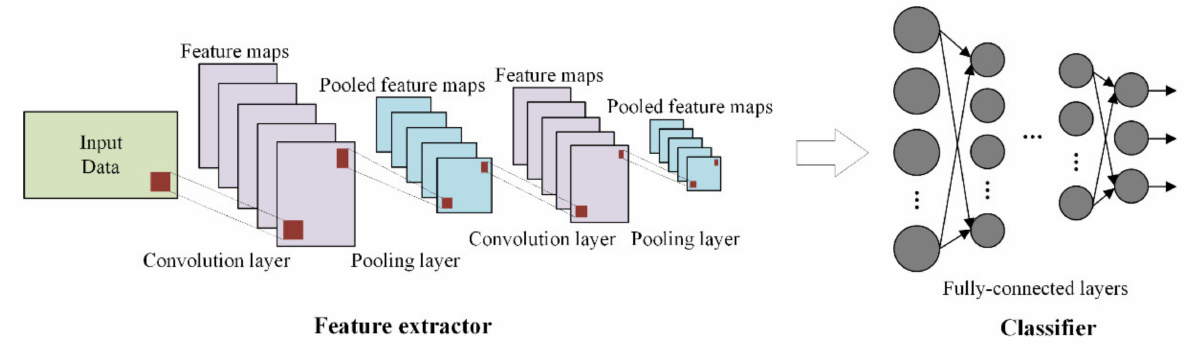
Figure 3. The basic structure of the Convolutional Neural Network (CNN)